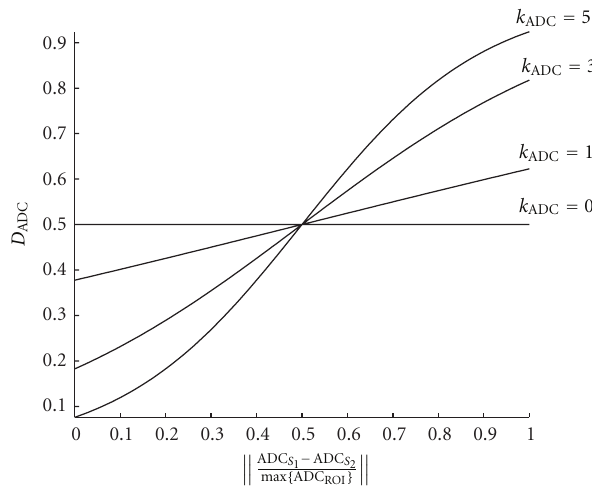
Figure 2: E ff ects of varying the tuning parameter k ADC from (4).